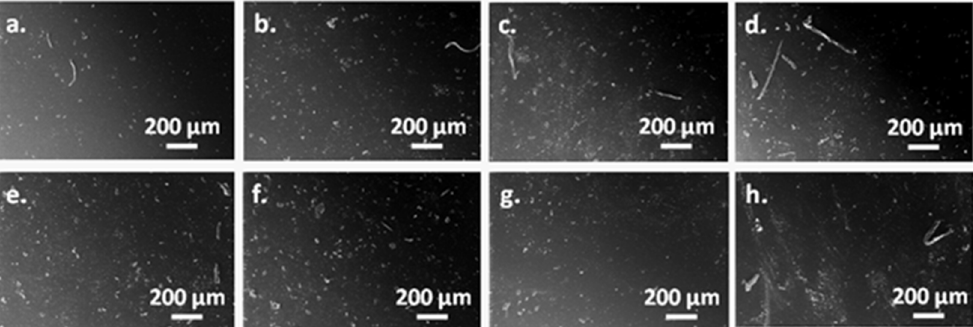
Figure 7. SEM images of masterbatches obtained with the two extruders: BMB220-1 ( a ), BMB220-2 ( b ), BMB330-1 ( c ), BMB330-2 ( d ), LMB220-1 ( e ), LMB220-2 ( f ), LMB330-1 ( g ), LMB330-2 ( h ).